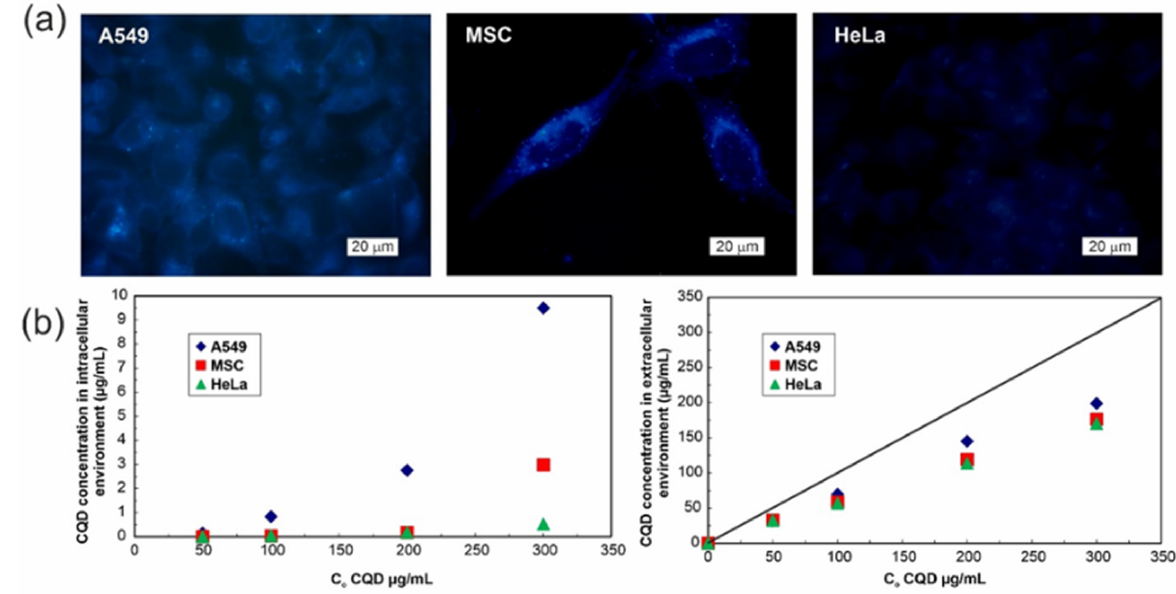
Figure 6. ( a ) Fluorescence microscopy images of A549, MSC, and HeLa cells after N-CQD absorption for 24 h in in vitro culture; ( b ) fluorescence-based determination of N-CQD concentration in cell lysates (left panel), and in the extracellular environment (right panel). Solid line corresponds to the initial N-CQD concentration in control samples (media without cells), and the difference between initial and measured N-CQD concentration indicates the amount of endocytosed mate- rial.